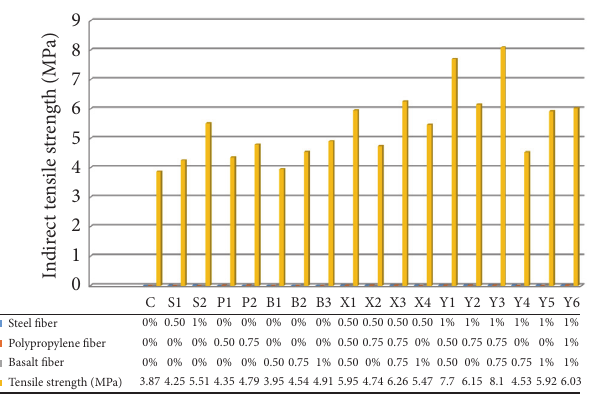
Figure 4: Comparison of indirect tensile strength for hybrid fibers at 28 days.